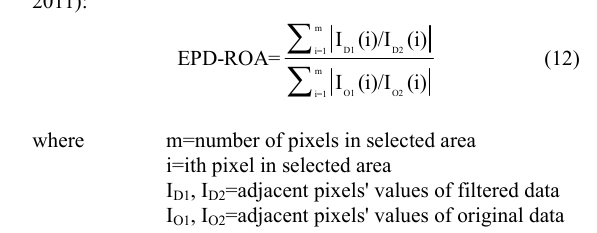
Figure 7. Original and filtered TerraSAR-X data